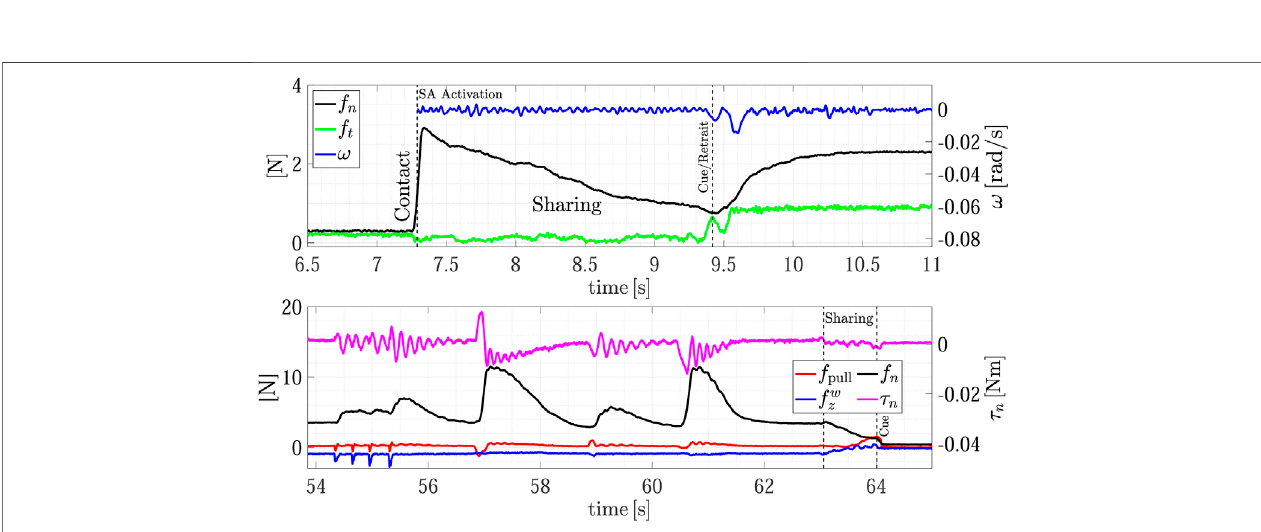
FIGURE 11 | Third experiment (Object C): forces and torque measured by the robot during the whole task execution (top plot); estimated slipping velocity (bottom) .